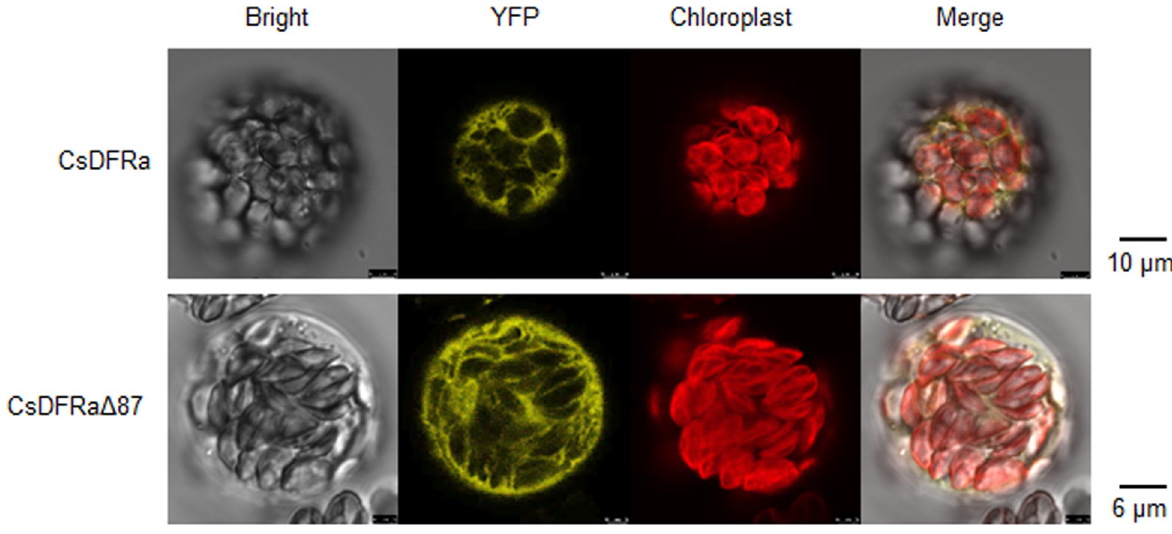
Fig 7. Subcellular location of CsDFRa and CsDFRa Δ 87.